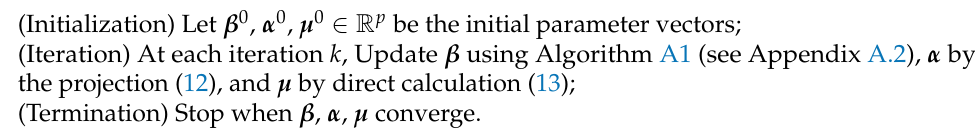
Algorithm 1 ADMM algorithm for the minimization of